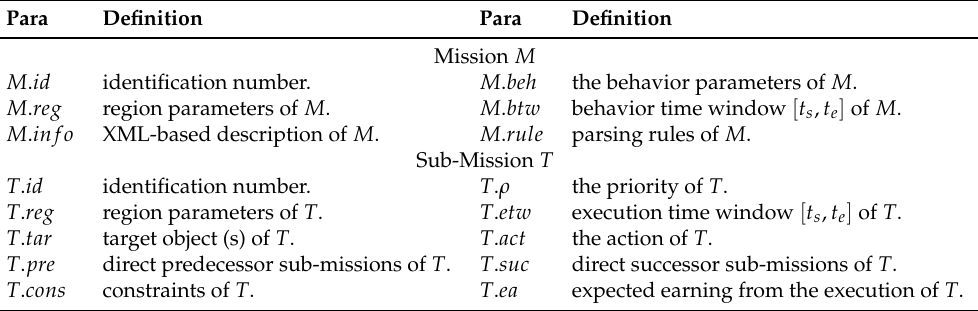
Table 1. Definitions of the Proposed Hierarchical Task